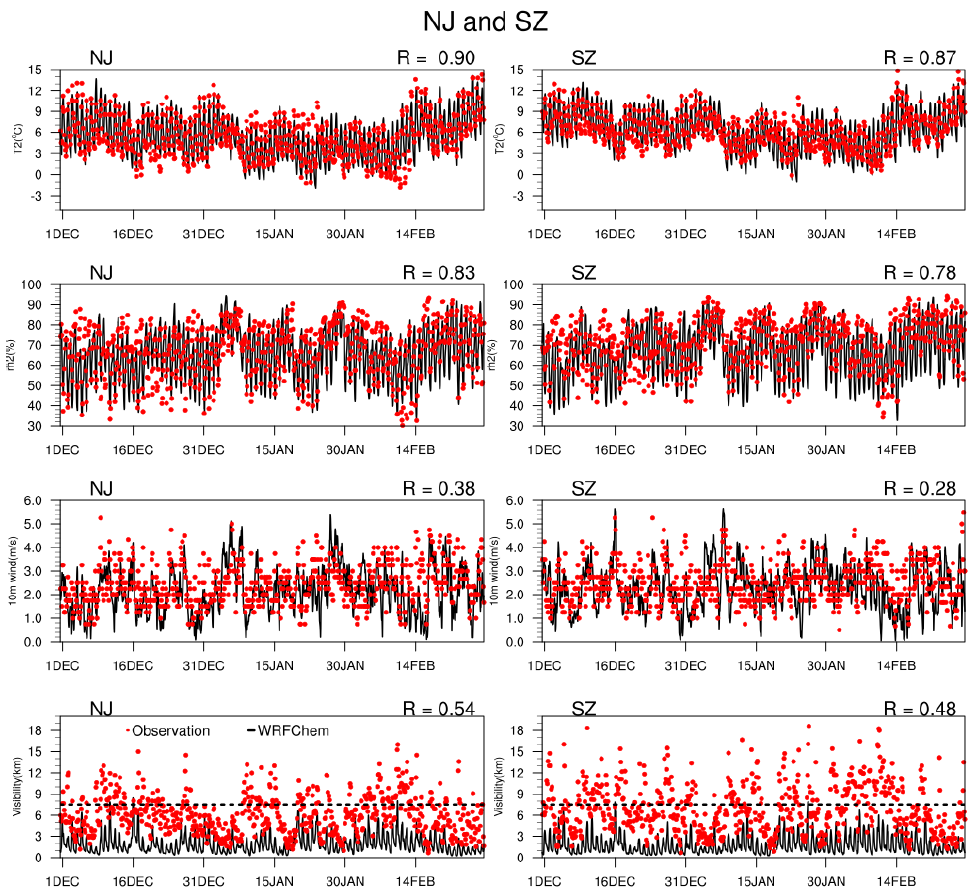
Figure 7. The temporal variation of multi-winter (2013–2017) mean 3-hourly T 2 , RH 2 , WS 10 , and VIS from top to bottom, obtained from observation (red dots) and WRF-Chem simulation (black curves) in the city of Nanjing City (NJ) (left column) and Suzhou City (SZ) (right column). Table 2. R, RMSE, MFE and MFB of the multi-winter (2013–2017) mean 3-hourly T 2 , RH 2 , WS 10 , and VIS simulated by WRF-Chem model compared to the observation in the four cities of XZ, YC, NJ, and SZ.